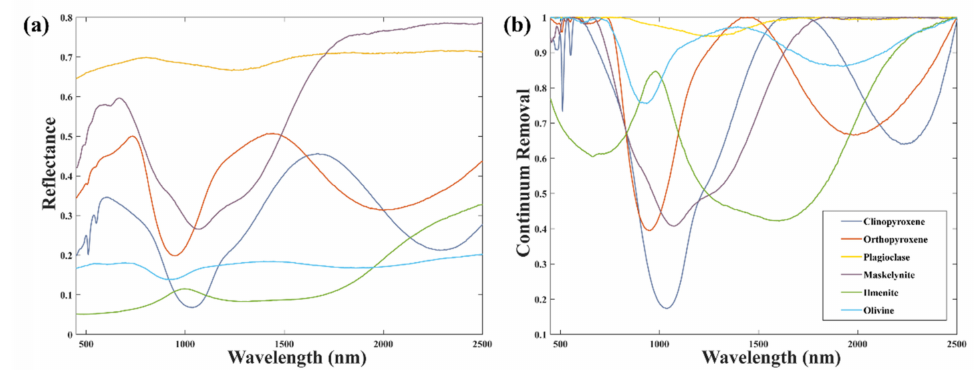
Figure 2. ( a ) Visible and near-infrared (VNIR) reflectance spectra and ( b ) spectra after continuum removal of endmembers used for spectral unmixing. Spectral ID: clinopyroxene (C1DL84A), or- thopyroxene (C1LR209), plagioclase (C1LR223), maskelynite (C1LR222), ilmenite (C1LR222), and olivine